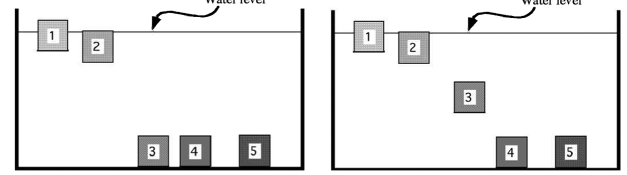
FIG. 3. Responses to the 5-block problem. Considered to be correct.